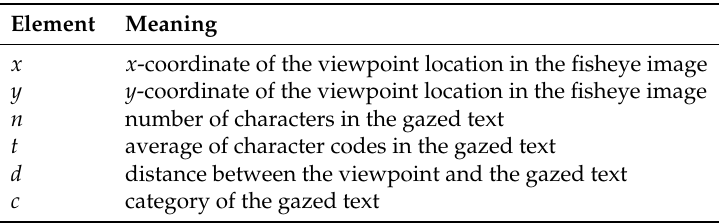
Table 2. Elements of feature